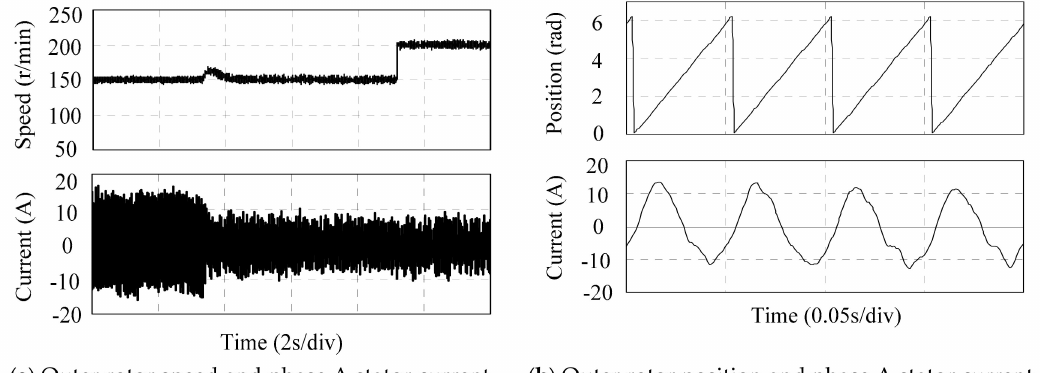
Figure 13. Experimental results of the outer rotor of the EVT machine with